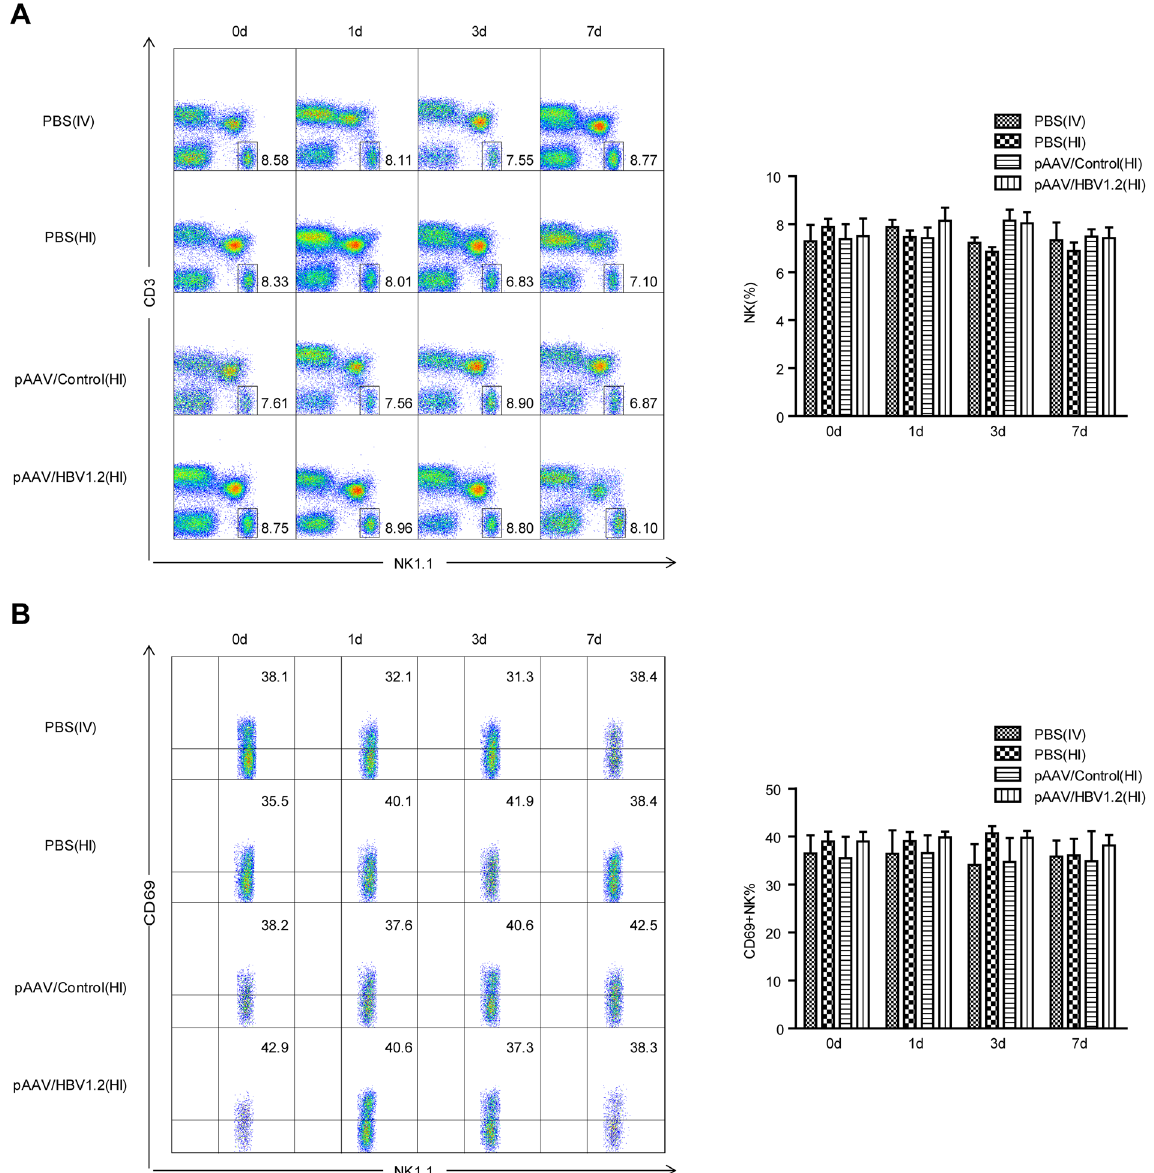
Figure 2. HBV does not seem to induce an active NK-cell response in the mouse model. C57BL/6 mice received 6 μ g of pAAV/HBV1.2 plasmid through hydrodynamic injection. Mice received HI of pAAV/control plasmid or HI of PBS or intravenous injection (IV) of PBS were used as controls. Lymphocytes were isolated from the liver at the indicated time points after injection. ( A ) The percentages of NK cells (CD3-NK1.1 + ) were analyzed using anti-NK1.1 and anti-CD3 antibodies. ( B ) The surface expression of CD69 on gated NK cells (CD3-NK1.1 + ) was also analyzed. Data are shown as mean ± SEM, n =